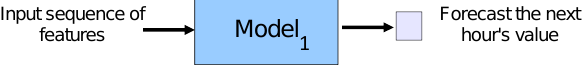
Figure 4. Forecaster Model 1 .